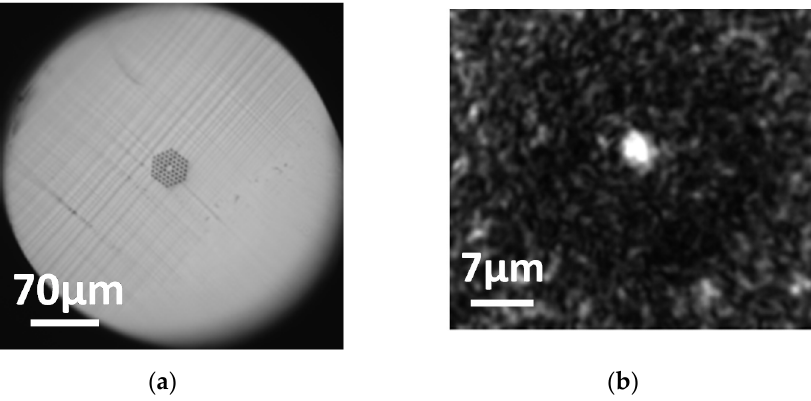
Figure 11. ( a ) 4-ring mPOF surface after blade treatment and cleaving. ( b ) Ouptut light pattern obtained. Blade temperature was 75 °C at a blade cutting speed of 0.5 mm/s.